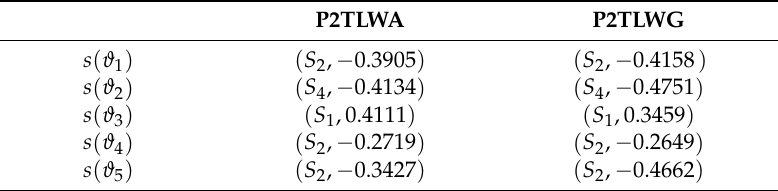
Table 10. Score results of alternatives ϑ i .